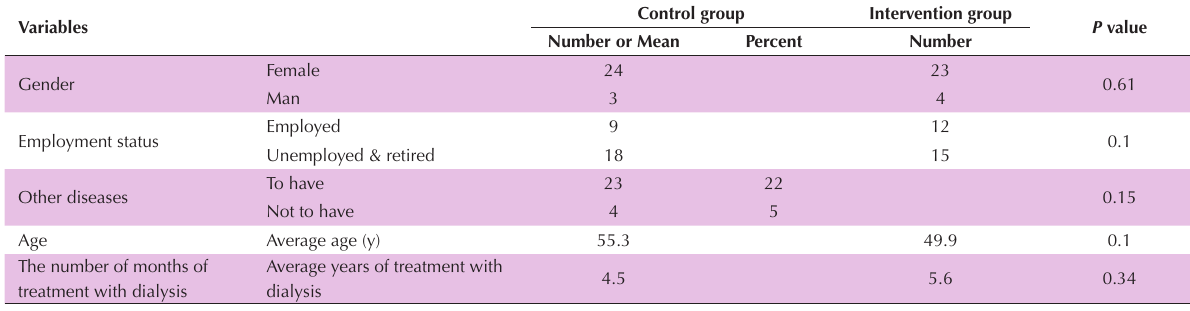
Table 1. Comparison of demographic variables between the two groups Variables